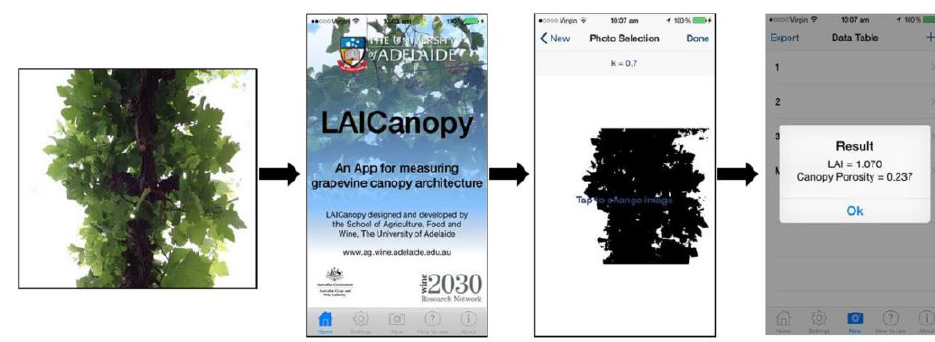
Figure 5. VitiCanopy app (Bruno Tisseyre, www.agrotic.org).